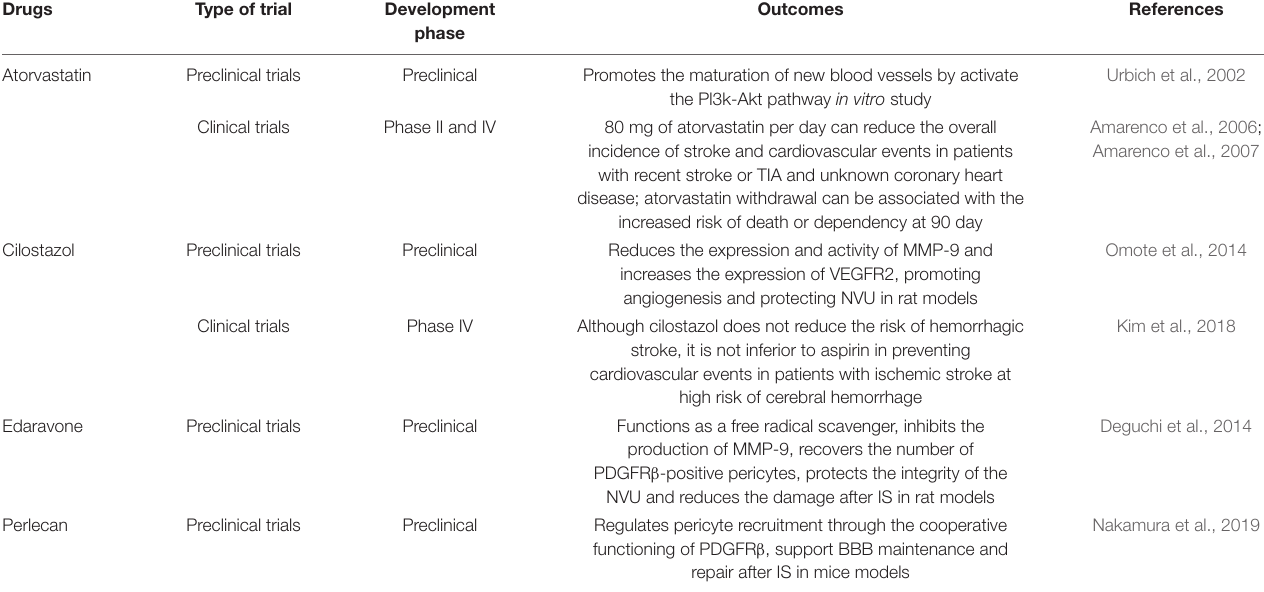
TABLE 2 | Drugs for IS that target